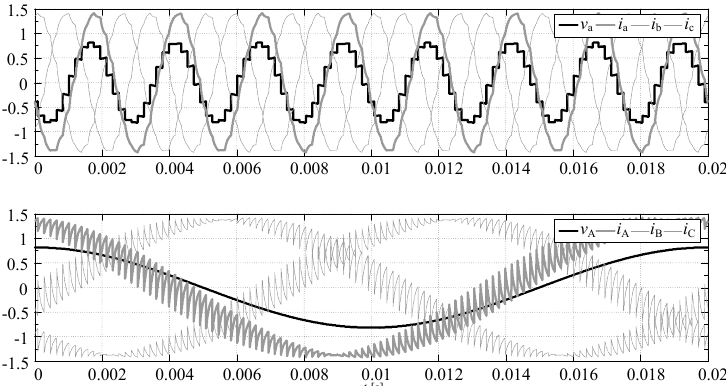
Figure 14. The waveforms of the phase voltages and currents at the output and input of the PWR controlled MMCCR for the S MC n switch state sequences: load model-1, q = 1.0, k f =